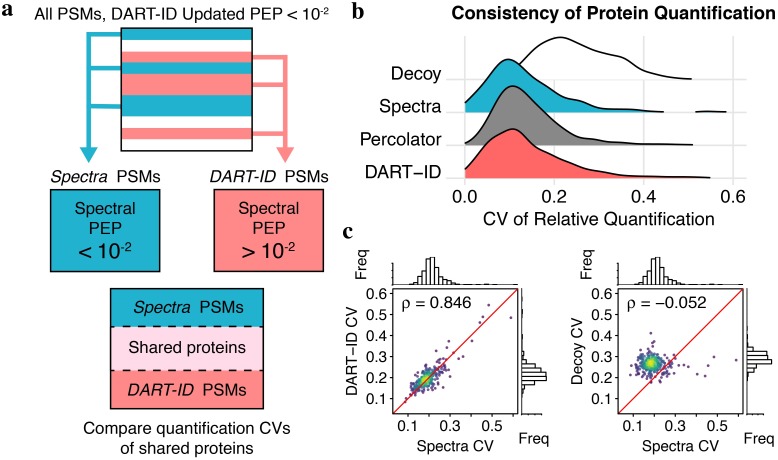
Validation of boosted PSMs by internal consistency.(a) Schematic for separating PSM subsets, where Spectra and DART-ID subsets of PSMs are disjoint. (b) Distributions of coefficient of variation (CVs) for each protein in each subset. Decoy is a subset of PSMs with their protein assignments randomized. (c) Comparing protein CVs of n = 275 proteins between the Spectra and DART-ID PSM subsets, and from the Spectra and Decoy subsets.